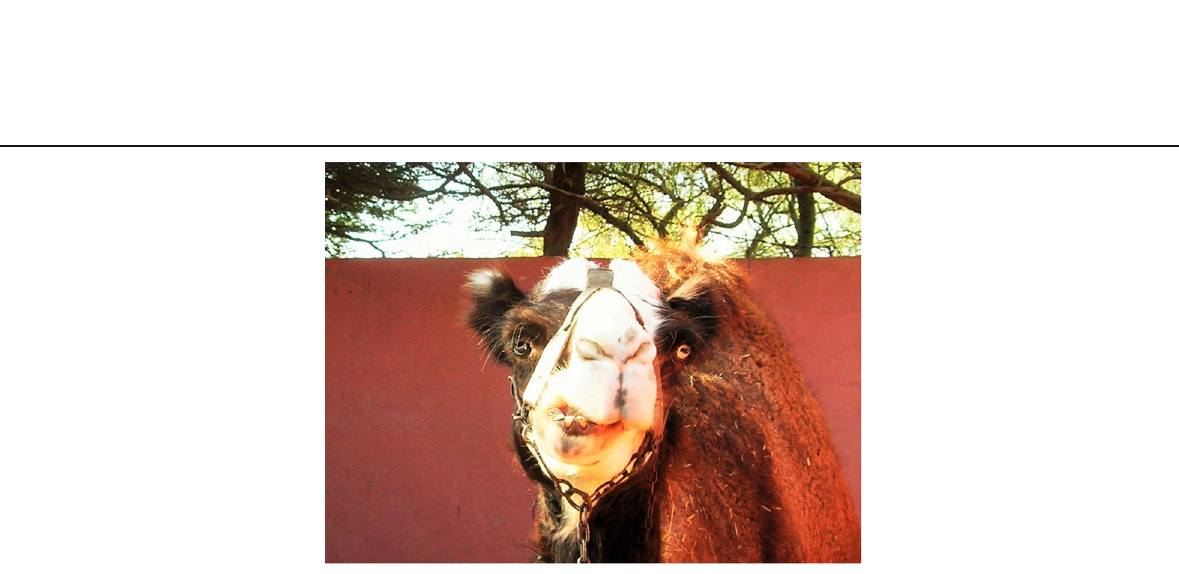
Figure 5 Head of an immature camel of the Canary Islands with eyes of different colours (Dioli 2013)